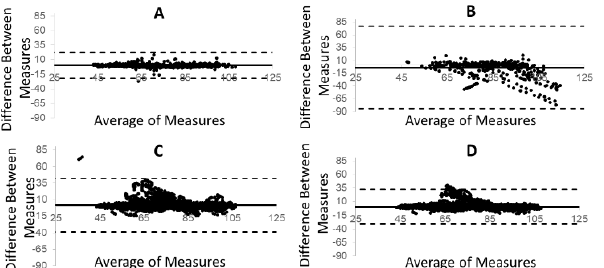
Figure 3. Bland–Altman plots of heart rate (bpm) during sedentary time for the ( A ) Apple Watch Figure 3. Bland – Altman plots of heart rate (bpm) during sedentary time for the ( A ) Apple Watch series 4, ( B ) Garmin Figure 3. Bland – Altman plots of heart rate (bpm) during sedentary time for the ( A ) Apple Watch series 4, ( B ) Garmin Figure 3. Bland – Altman plots of heart rate (bpm) during sedentary time for the ( A ) Apple Watch series 4, ( B ) Garmin Figure 3. Bland – Altman plots of heart rate (bpm) during sedentary time for the ( A ) Apple Watch series 4, ( B ) Garmin series 4, ( B ) Garmin Forerunner 735XT, ( C ) Jabra Elite earbuds, and ( D ) Scosche Rhythm 24 devices Forerunner 735XT, ( C ) Jabra Elite earbuds, and ( D ) Scosche Rhythm 24 devices compared to the Polar H7. Dashed lines Forerunner 735XT, ( C ) Jabra Elite earbuds, and ( D ) Scosche Rhythm 24 devices compared to the Polar H7. Dashed lines Forerunner 735XT, ( C ) Jabra Elite earbuds, and ( D ) Scosche Rhythm 24 devices compared to the Polar H7. Dashed lines Forerunner 735XT, ( C ) Jabra Elite earbuds, and ( D ) Scosche Rhythm 24 devices compared to the Polar H7. Dashed lines represent 95% limits of agreement. compared to the Polar H7. Dashed lines represent 95% limits of agreement. represent 95% limits of agreement. represent 95% limits of agreement. represent 95% limits of agreement.